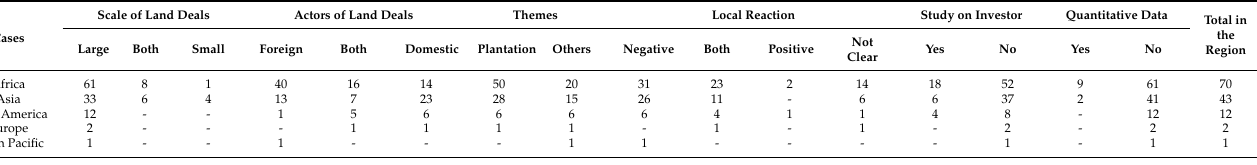
Figure 1. The number of case studies ( n = 128). Table 1. Key information of the selected case studies.